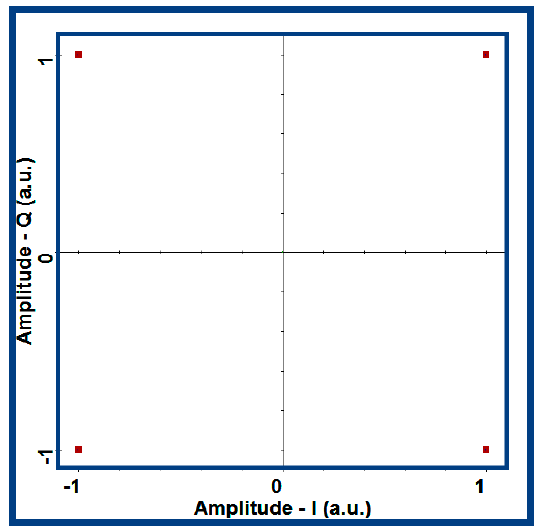
Figure 13. Constellation of the filtered 4QAM-OFDM signal in the MT.